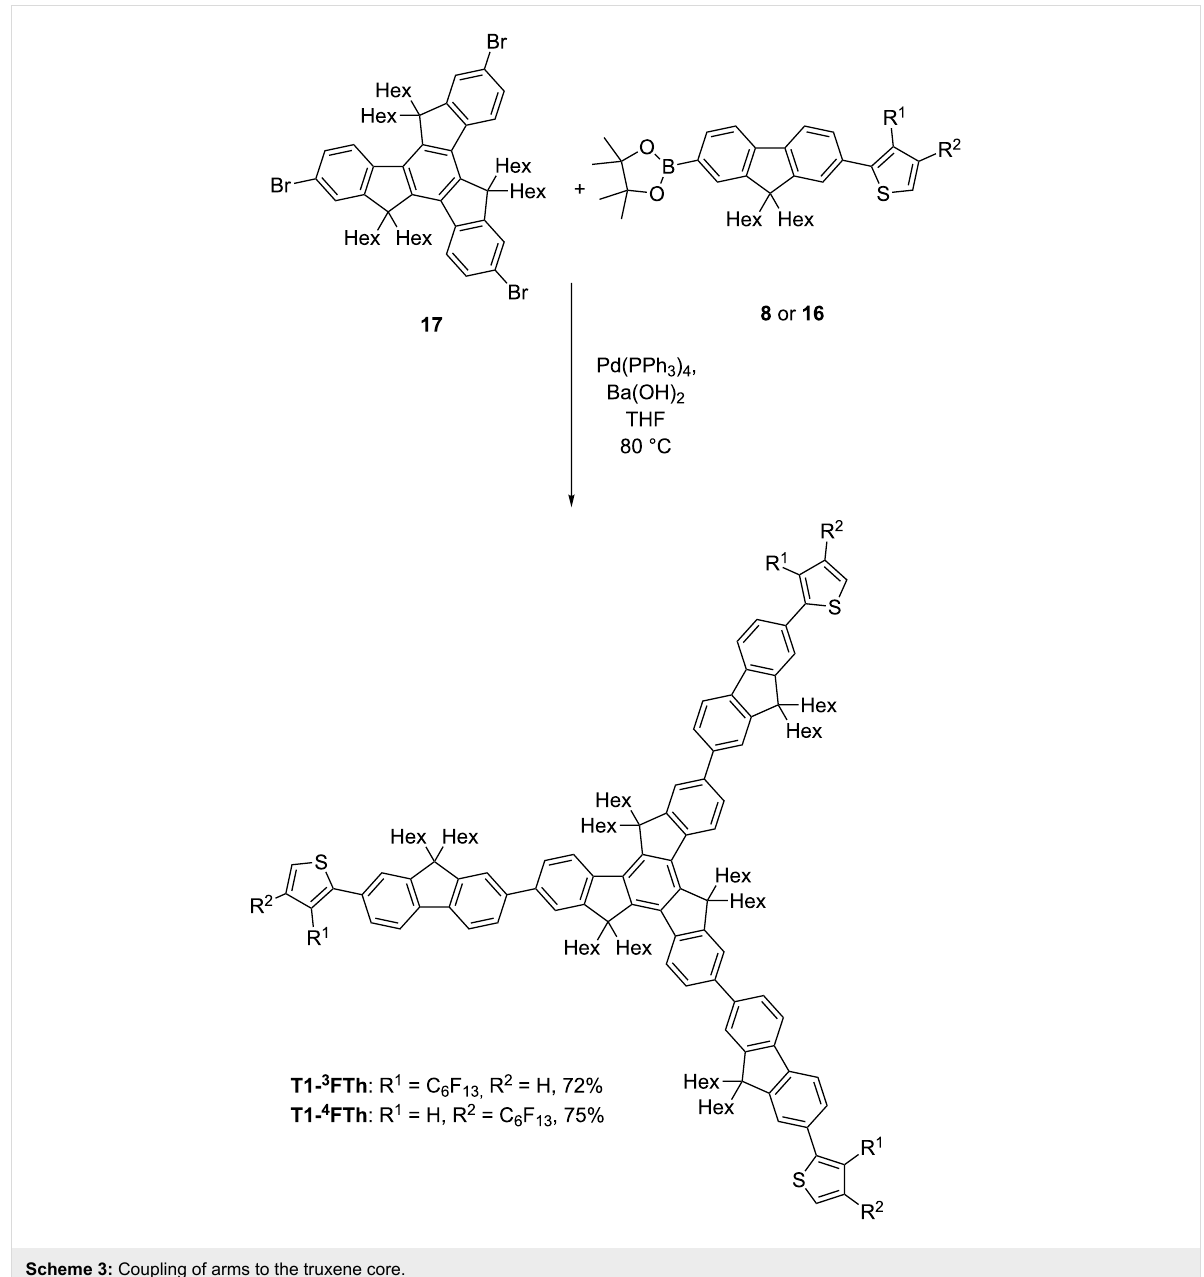
Scheme 3: Coupling of arms to the truxene